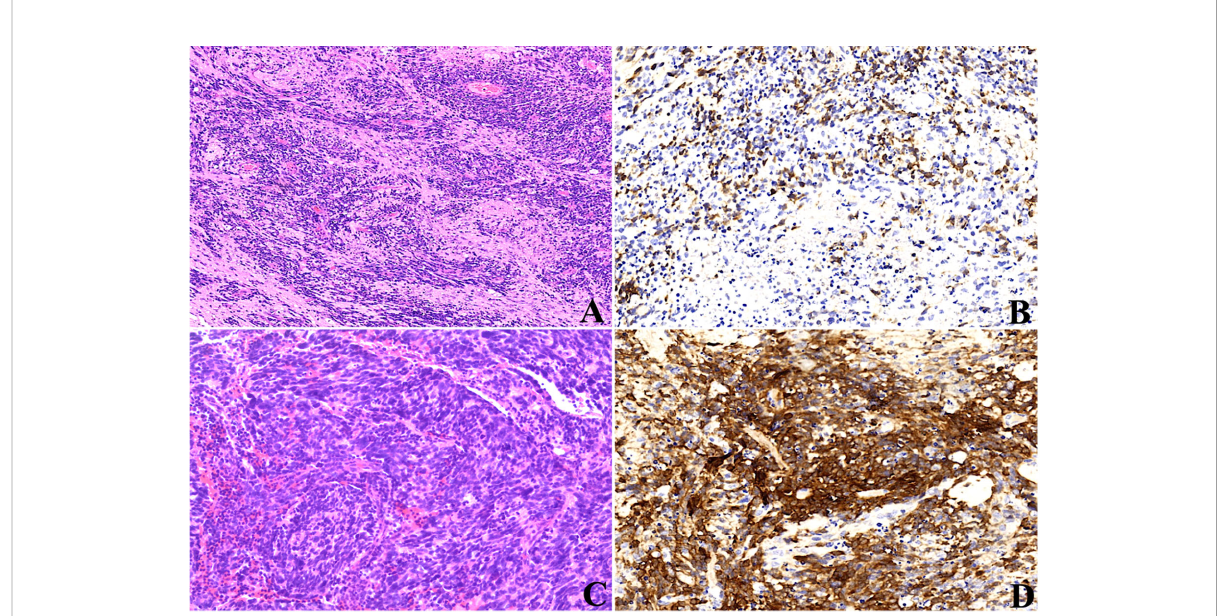
FIGURE 7 Histopathological progression of case 4, the tumor presented as the biphasic pattern of ETANTRs at the initial surgery (A) , and Lin28A expression was positive (B) ; recurrent tumor after surgery showed anaplasia in large cells with cellular pleomorphism and prominent nucleoli (C) ; the expression of Lin28A was stronger and more intense (D) than that of the primary